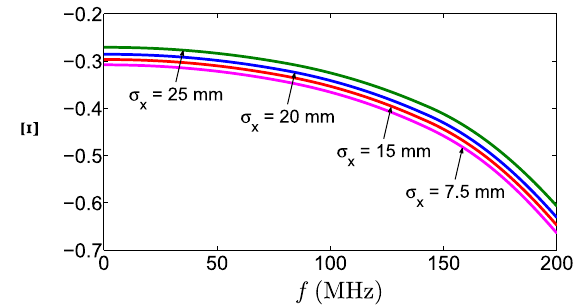
FIG. 19. Quadrupole signal in the frequency domain for different values of the beam